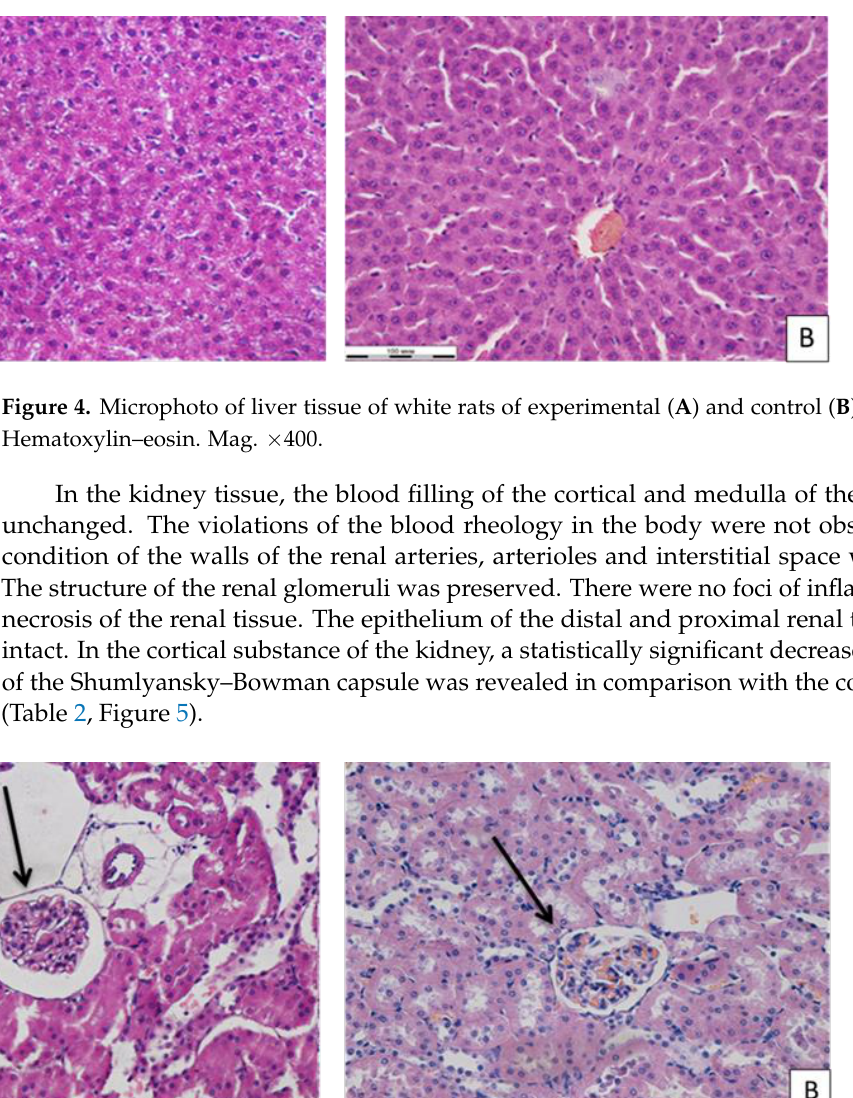
Figure 5. Microphoto of kidney tissue of white rats of experimental ( A ) and control ( B ) groups. ↑ — Shumlyansky – Bowman chamber. Hematoxylin – eosin. Mag. ×400. ↑ —Shumlyansky–Bowman chamber. Hematoxylin–eosin. Mag. ×